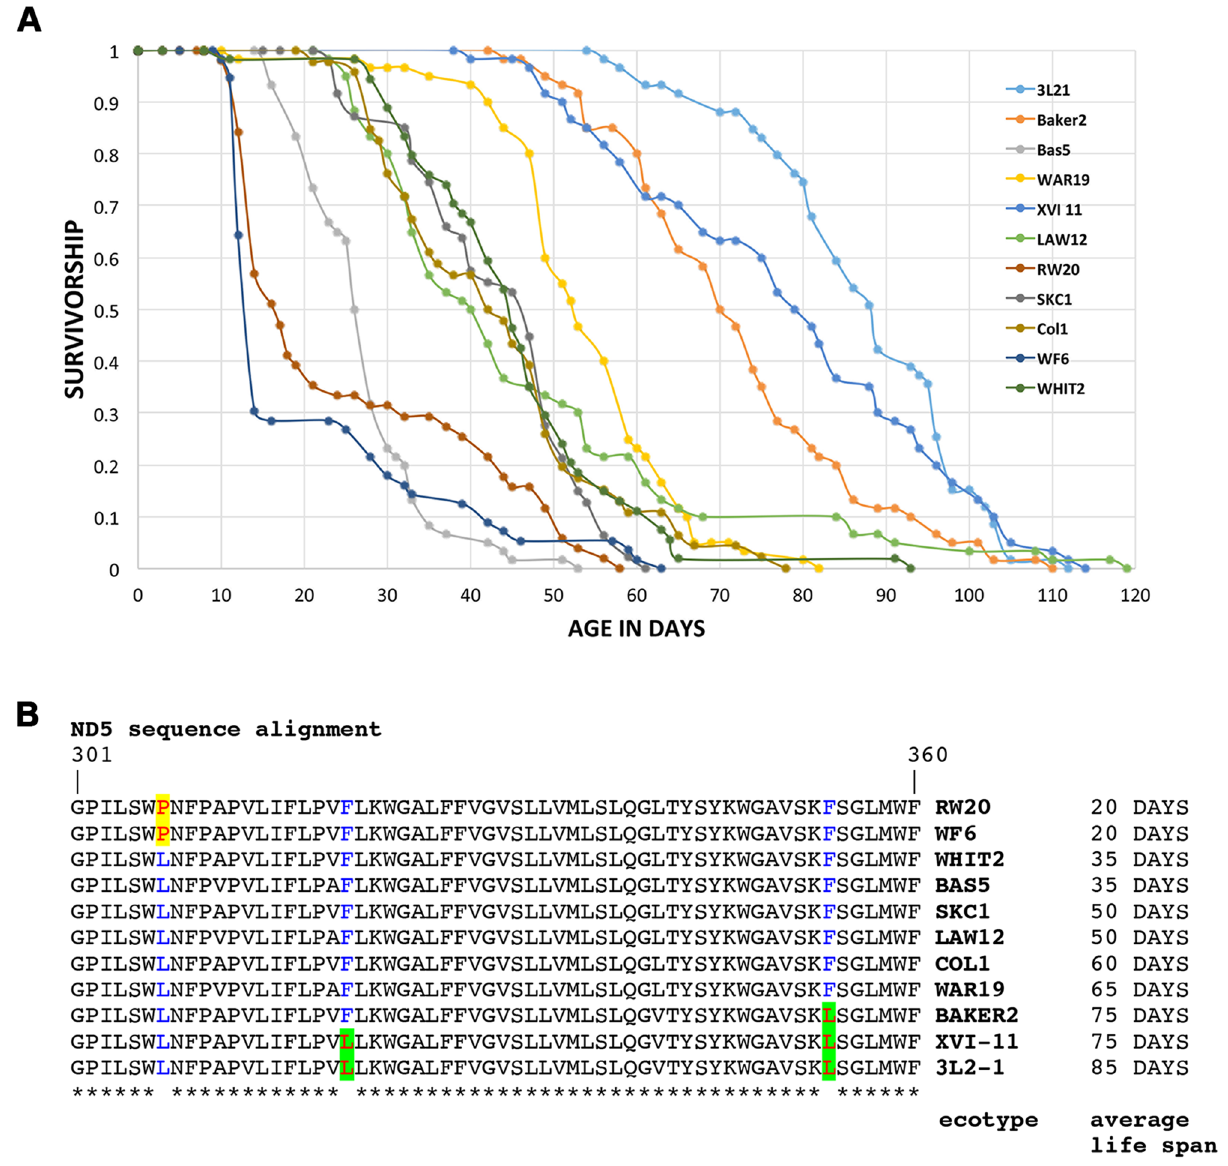
Figure 1. Adult survivorship curves and ND5 sequence alignments. ( A ) Genetic differences of adult survivorship among populations of D. pulex . Each line represents a specific clone. Pond clones: RW20, WF6, WHIT2, SKC1, and Col1. Lake clones: Bas5, LAW12, WAR19, Baker, XVI-11, and 3L21. ( B ) ND5 sequence alignments in the order of increasing life spans. Only a short relevant region of the sequence alignments is shown. Red font with yellow highlighting: amino acids specific to the short-lived clones, red font with green highlighting: amino acids specific to the long-lived clones, blue font: positions where amino acid changes are